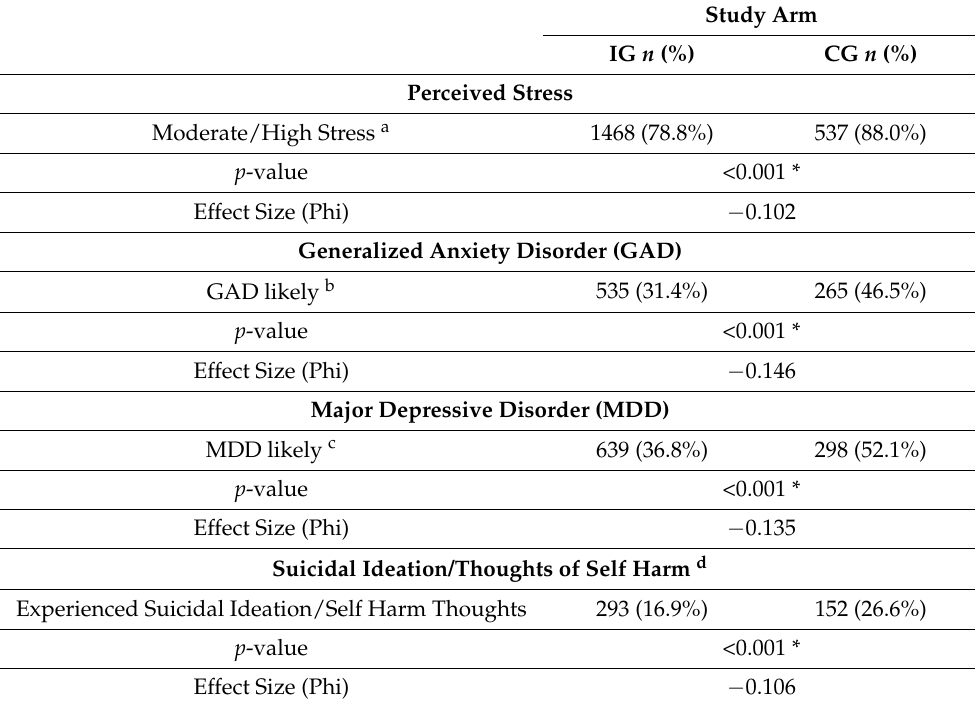
Table 3. Chi-square test of association between prevalence of clinical parameters and study